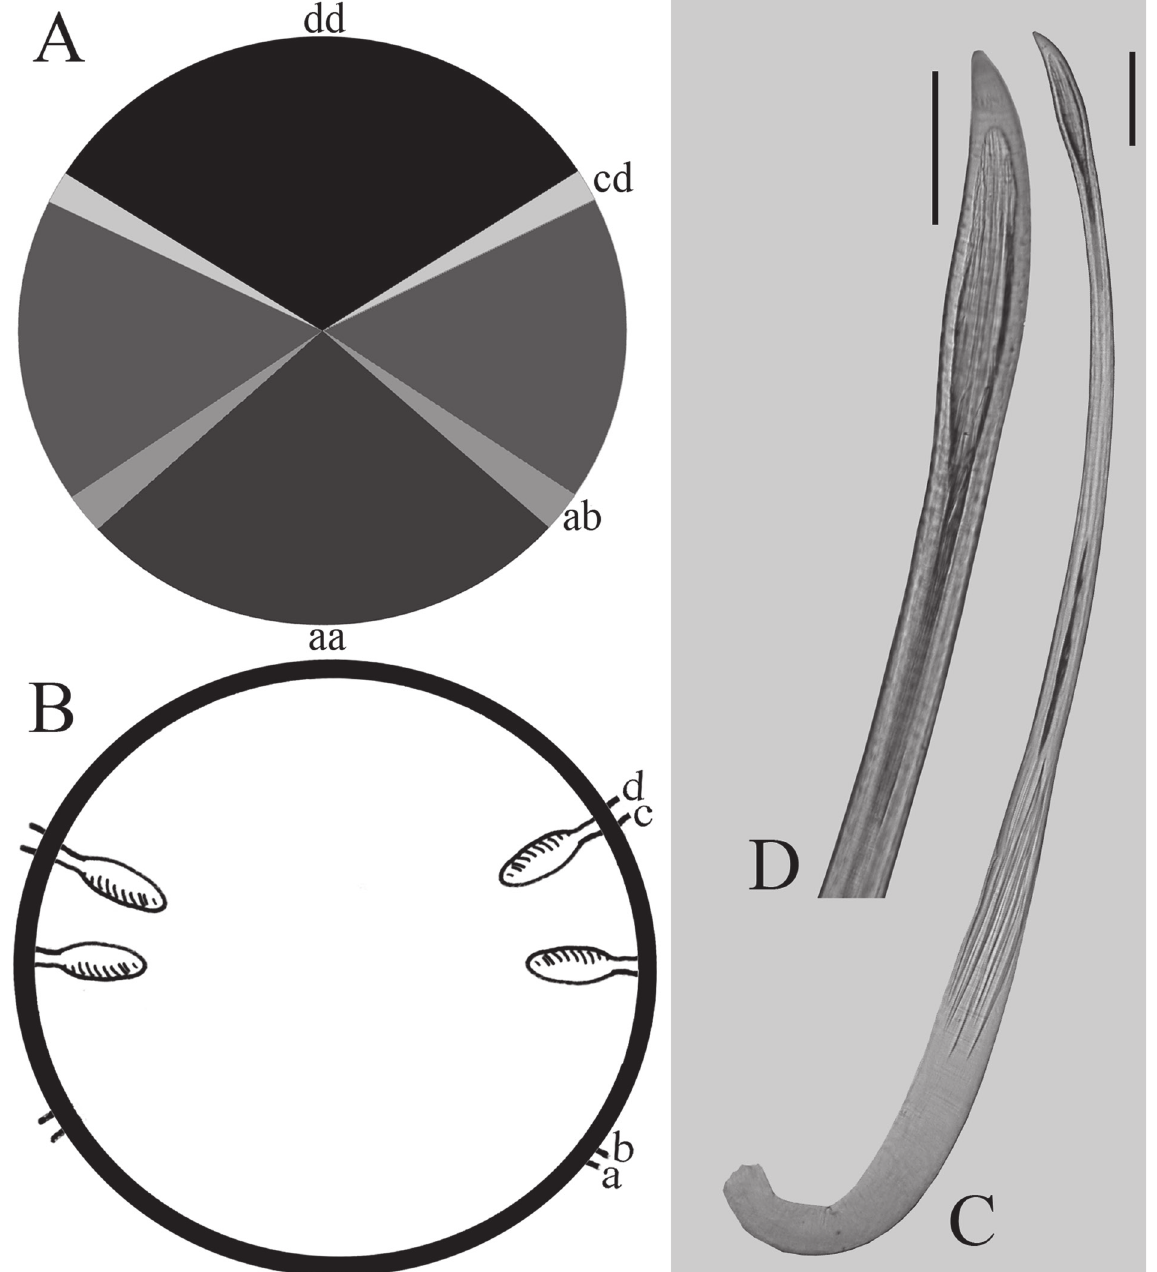
Fig. 2. Kynotus ankisiranus sp. nov. A . Setal arrangement, a, b, c, d representing setal lines. B . Spermathecae, schematic representation. C . Genital seta. D . Tip of the genital seta. Scale bars = 0.1